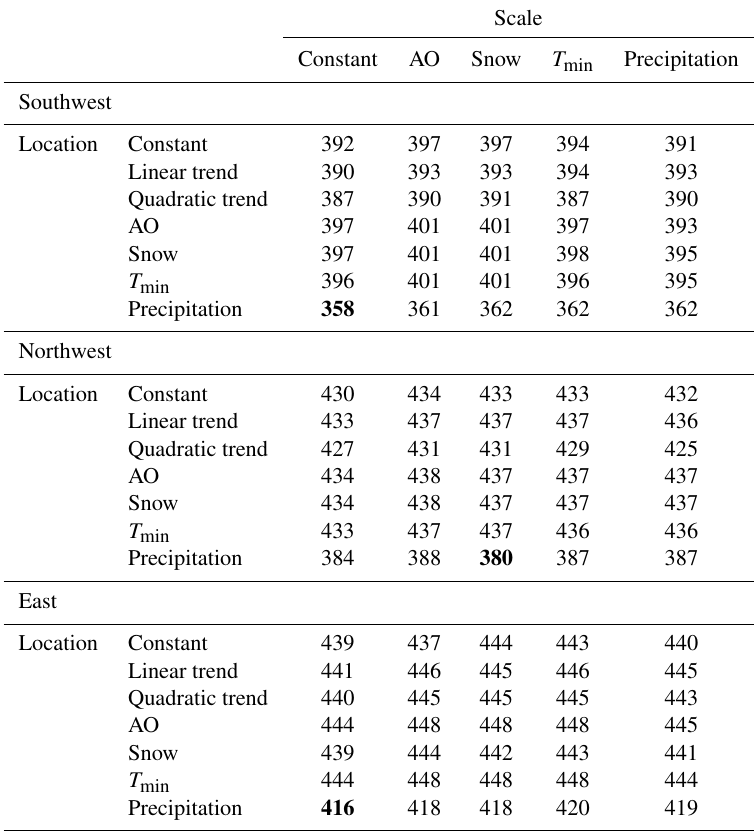
Note that bold BIC values mean the lowest values.